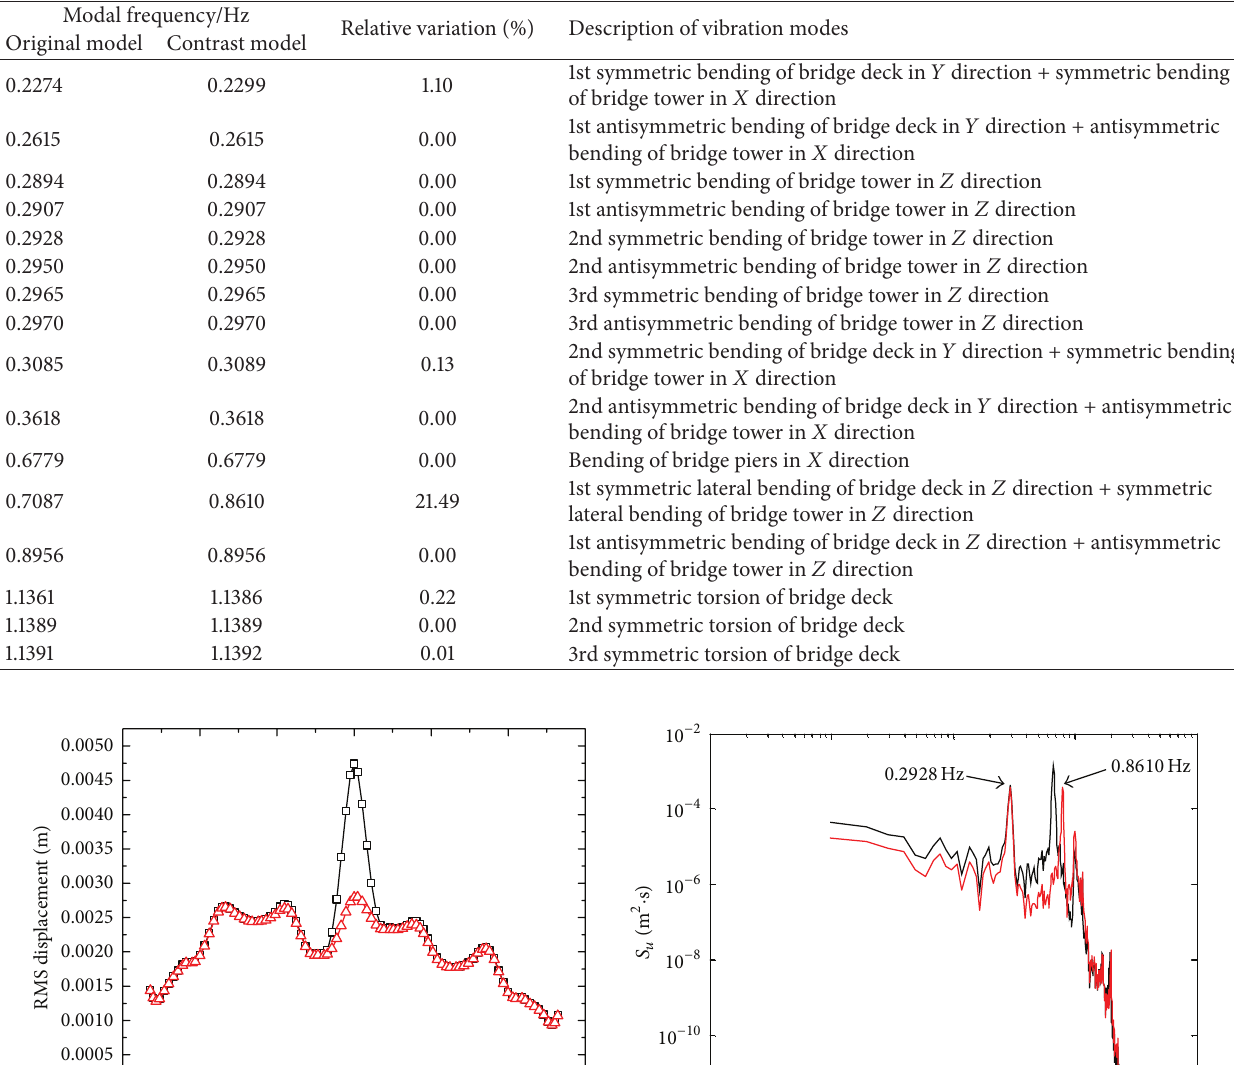
Table 4: Influence of rigid hinge on the dynamic characteristics of the bridge.